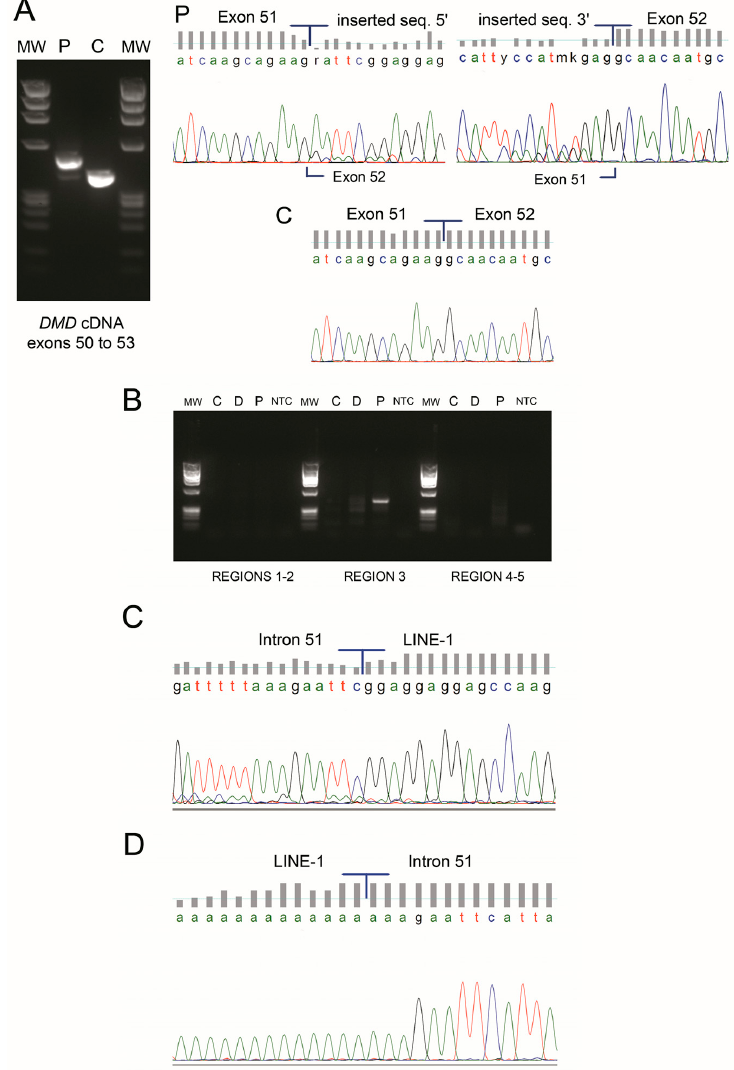
Figure 2. ( A ) cDNA analysis of DMD transcript revealed an abnormal PCR product with higher molecular weight in the patient (P) which was not detectable in a control sample (C). Sequencing electropherogram shows an insertion of 103 nucleotides between exons 51 and 52. A residual wild-type transcript is present in the patient sample (faint PCR band). ( B ) PCR amplification of five candidate regions to identify the long interspersed nuclear element (LINE-1) insertion site in intron 51 of DMD (C—control, D—control with a deletion of intron 51, P—patient, MW—molecular weight marker, NTC—no template control). A single amplicon was obtained in the patient sample for the candidate region 3. ( C ) Upon sequencing, the exact location of the LINE-1 in intron 51 was mapped to lie between positions c.7542+8951 and c.7542+8952 (NM_004006.2). ( D ) The 3 ′ insertion site was confirmed through a specific PCR followed by sequencing; the LINE-1 poly-A tail is also seen. The patient’s daughter was seen to be a carrier of the LINE-1 insertion mutation. Additional family members (the patient’s healthy brother and two sisters presenting at-risk haplotypes) were